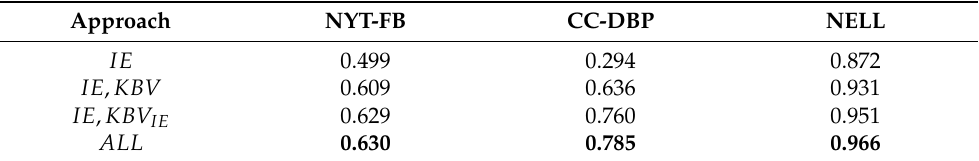
Table 2. Results: Area under precision recall curve (AUC) on KBP datasets.